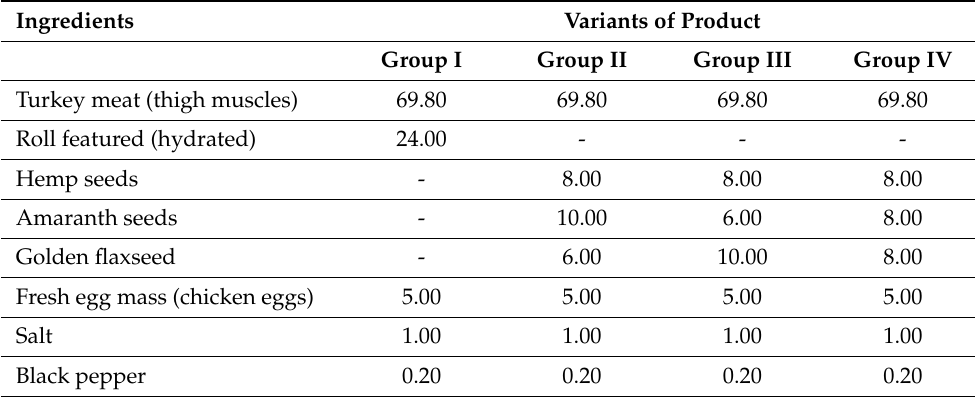
Table 1. The recipe composition of the poultry p â t é s